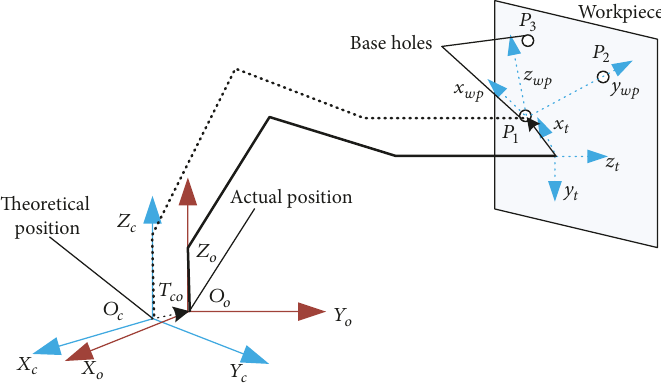
Figure 7: Base detection theorem of two-base holes.